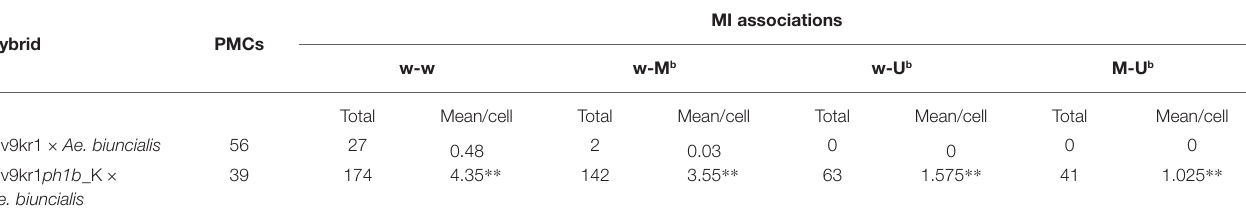
TABLE 4 | Frequency of MI homoeologous associations in bread wheat (Mv9kr1) × Aegilops biuncialis MvGB1733 hybrids.